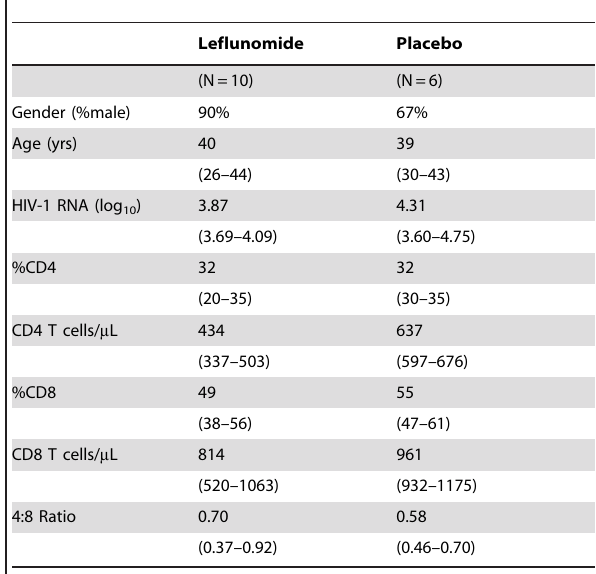
Table 1. Participant baseline characteristics A (median value with interquartile range in